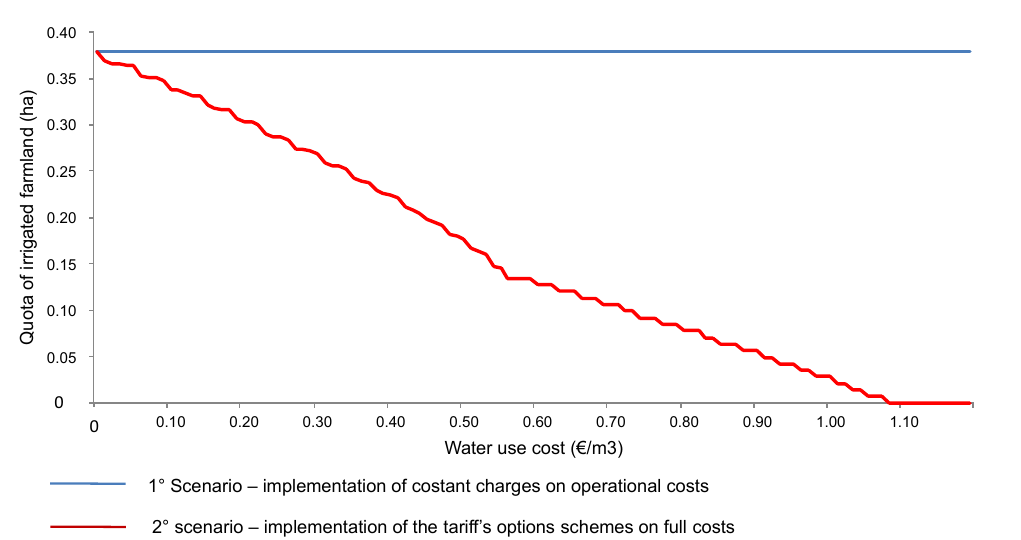
Figure 4. Quota of irrigated farmland trends with increasing irrigation costs for the two